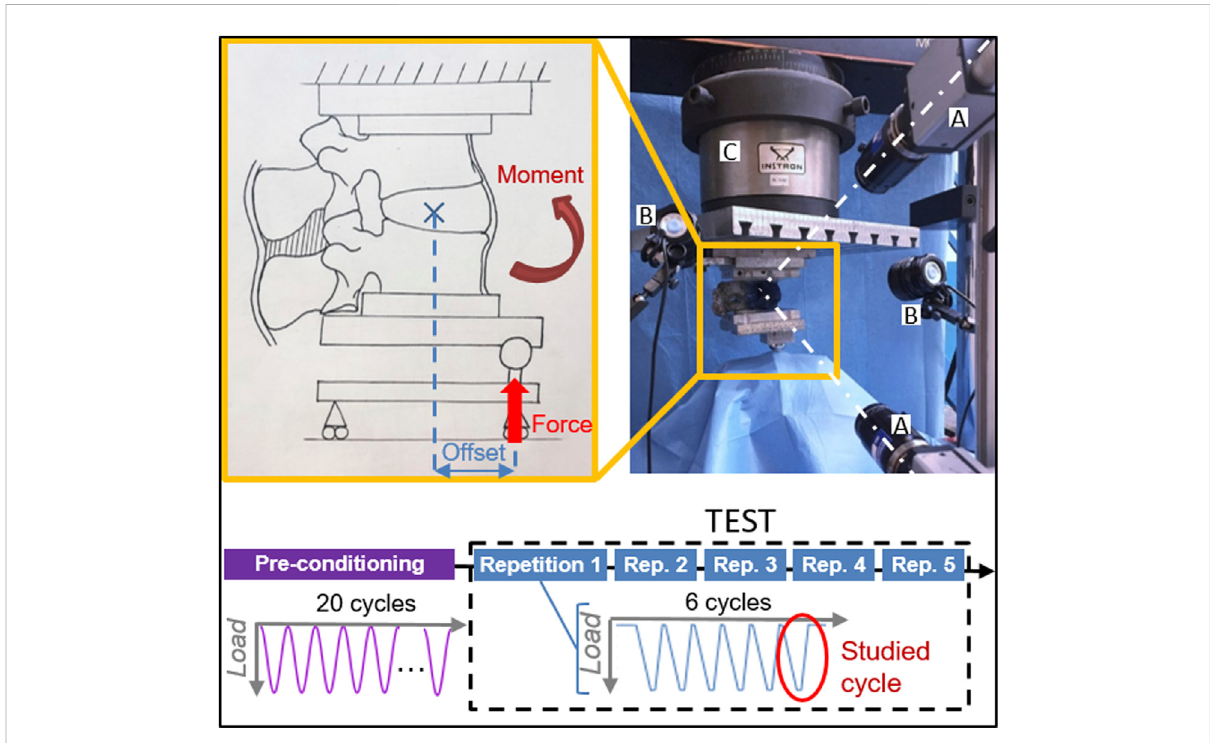
FIGURE 3 Testing protocol with the experimental setup of the test in fl exion and composition of the test sequence. Two cameras (A) targeted the specimen, which was illuminated by high-intensity LEDs (B). The force applied by the testing machine (C) was delivered with an offset, resulting in a combination of a force and a